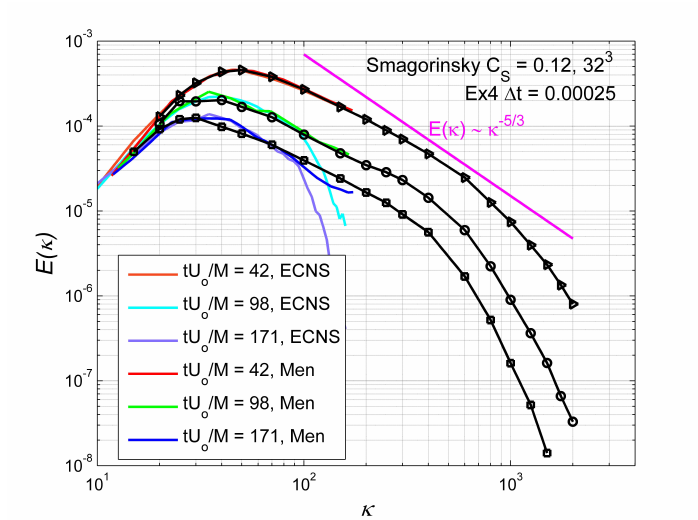
Figure 8. A comparison between the ECNS with the Smagorinsky model and C S = 0.12 on a 32 3 grid and a pseudo-spectral code with the Germano dynamic model on a 32 3 ( Men in the plot) from